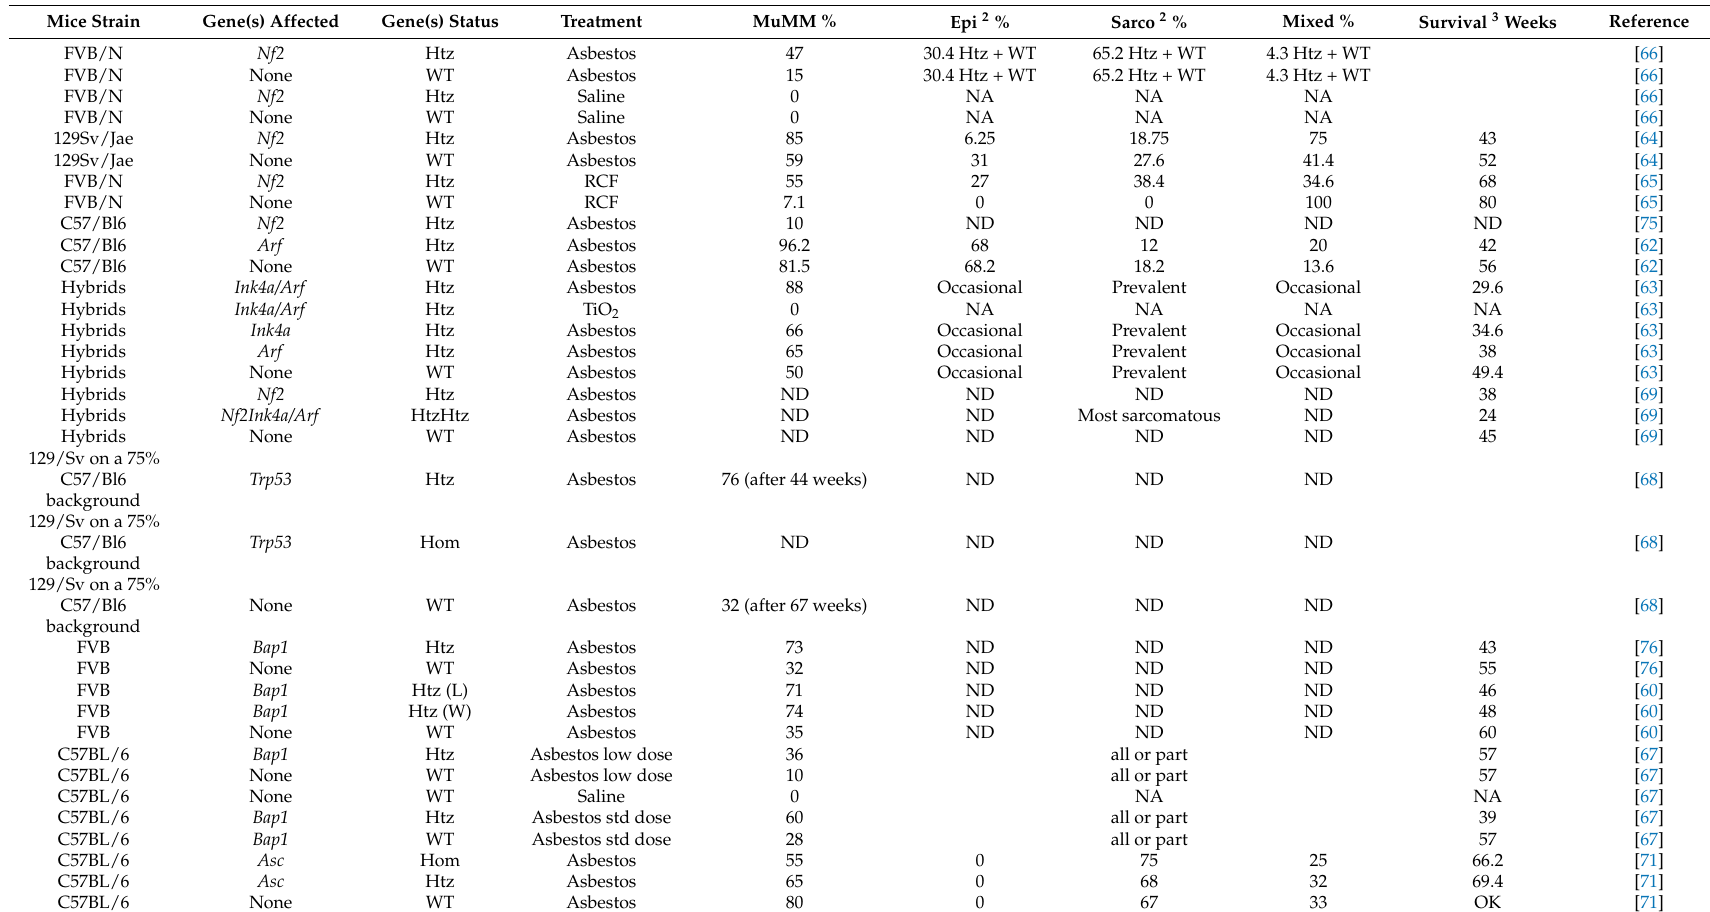
Table 2. Induction of MuMM in GEM (Induction of MuMM by injection of